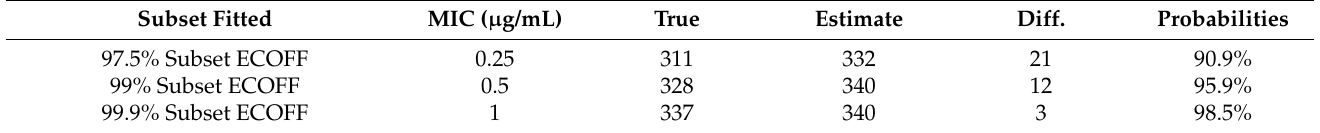
Table 1. The upper limit and probability of MIC distribution.